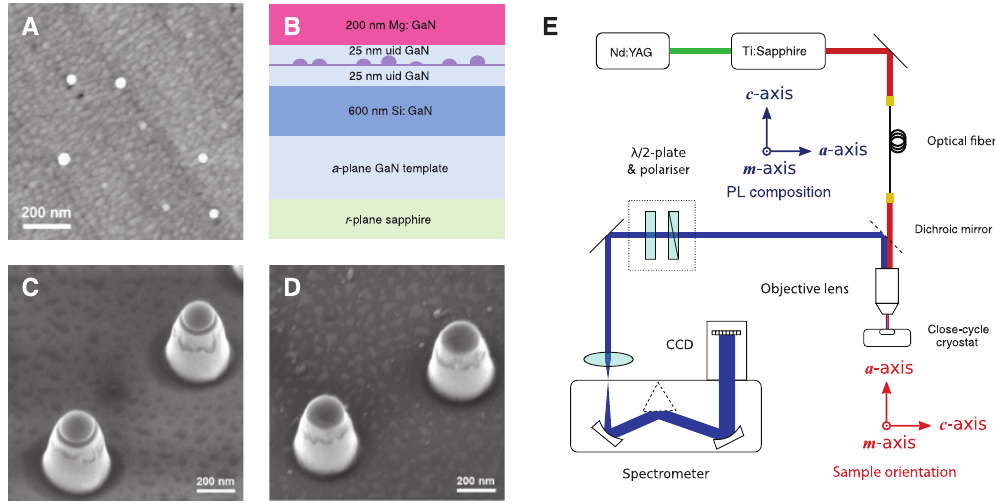
Figure 1: Sample structure, processing, and setup of optical experiment. (A) AFM image of an uncapped QD sample grown on a -plane GaN template, with z -scale = 5 nm. (B) Schematic material structure for the nanopillar p-i-n sample with InGaN QDs. Also shown are SEM images (30 ° tilted view) of nanopillars (C) before and (D) after the removal of the residual silica nanospheres. (E) Schematic of polarization-resolved micro-photoluminescence ( μ -PL) setup, illustrating the sample orientation and consequent PL composition before passing through the polarizer in the plane of